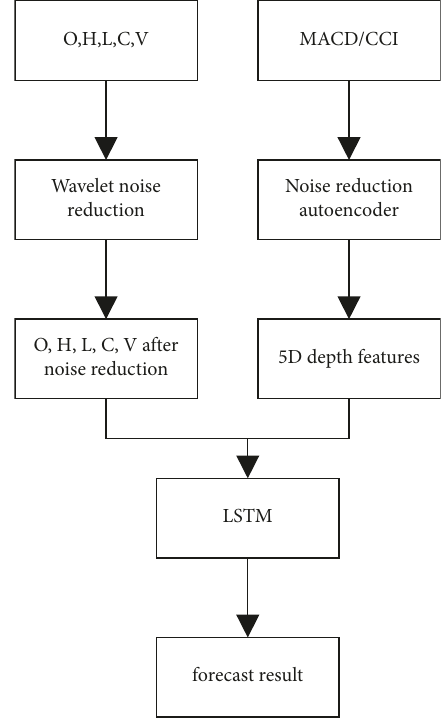
Figure 2: Network model structure.